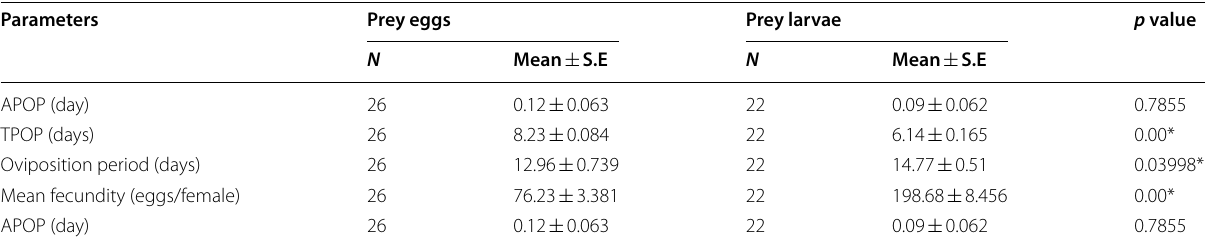
Table 2 Reproductive characteristics of Blattisocius mali fed on eggs and larvae of Tyrophagus putrescentiae